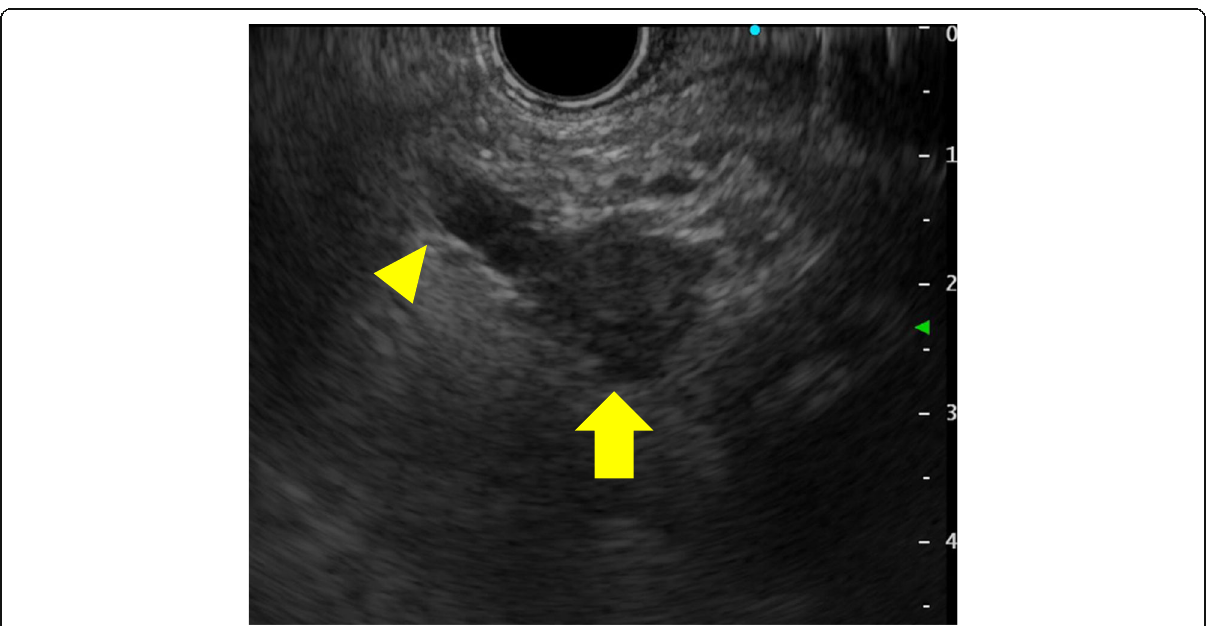
Fig. 5 EUS revealing 16-mm hypoechoic tumor (arrow) with irregular margin. There was intraluminal growth without stricture of pancreatic duct (arrow head)